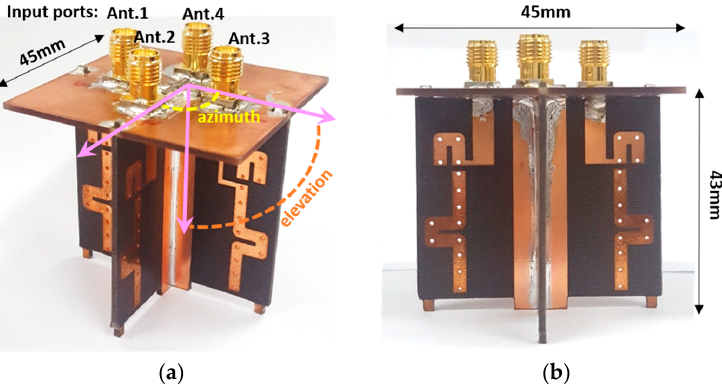
Figure 9. Fabrication of the proposed array antenna in di ff erent views: ( a ) elevation and azimuth axes, and ( b )